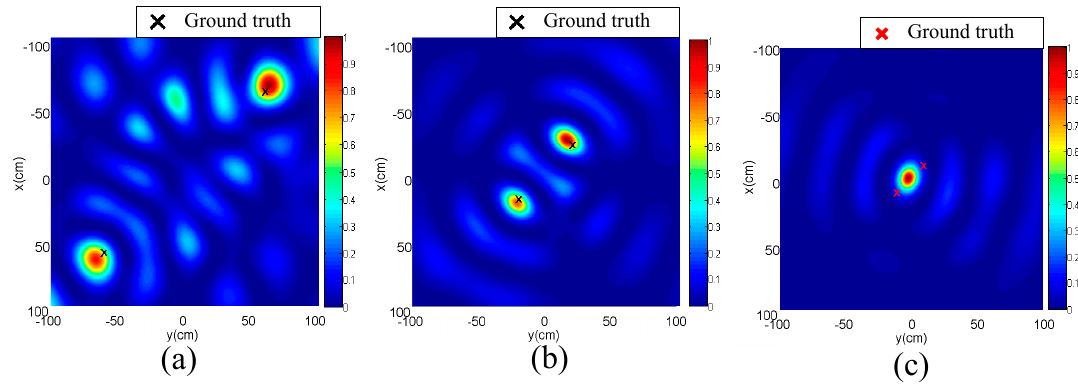
Figure 12. The results without weighted spatial averaging: ( a ) 170 cm, ( b ) 50 cm, and ( c ) 30 cm interval.